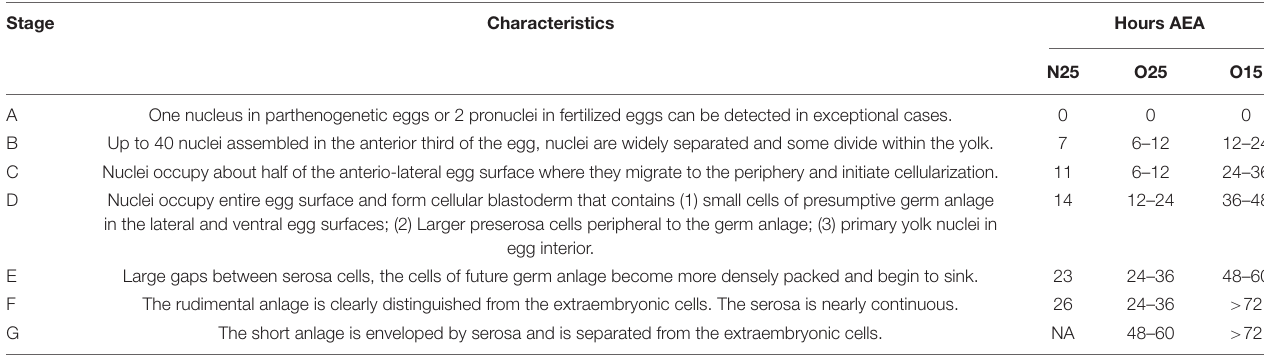
TABLE 1 | Brief description of the stages of early embryogenesis in B. mori .